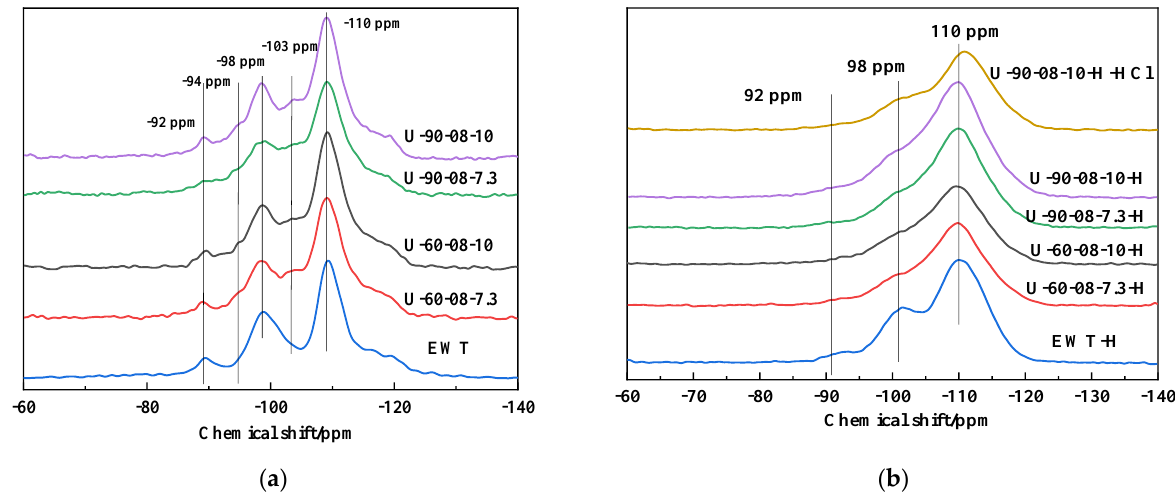
Figure 13. 29 Si MAS NMR of ( a ) as made and ( b ) calcined